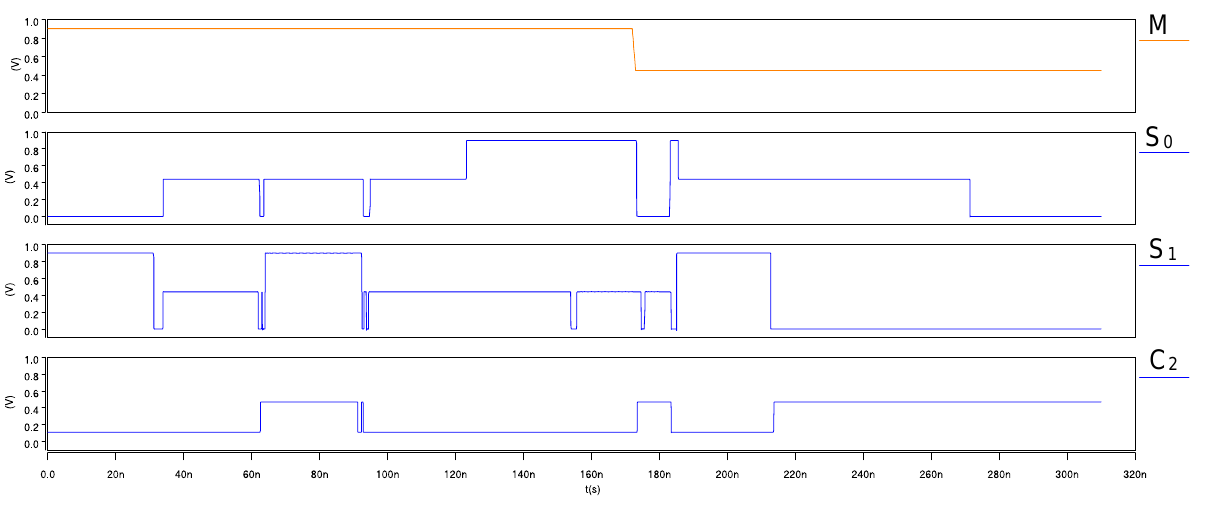
Figure 14. Transient response of CNTFET-RRAM ternary adder–subtractor module. The ternary 2-trit multiplier, input waveforms, and its transient response are shown in Figures 15 and 16, respectively. Similarly, for the ternary comparator, input waveforms and its transient response are shown in Figures 17 and 18,